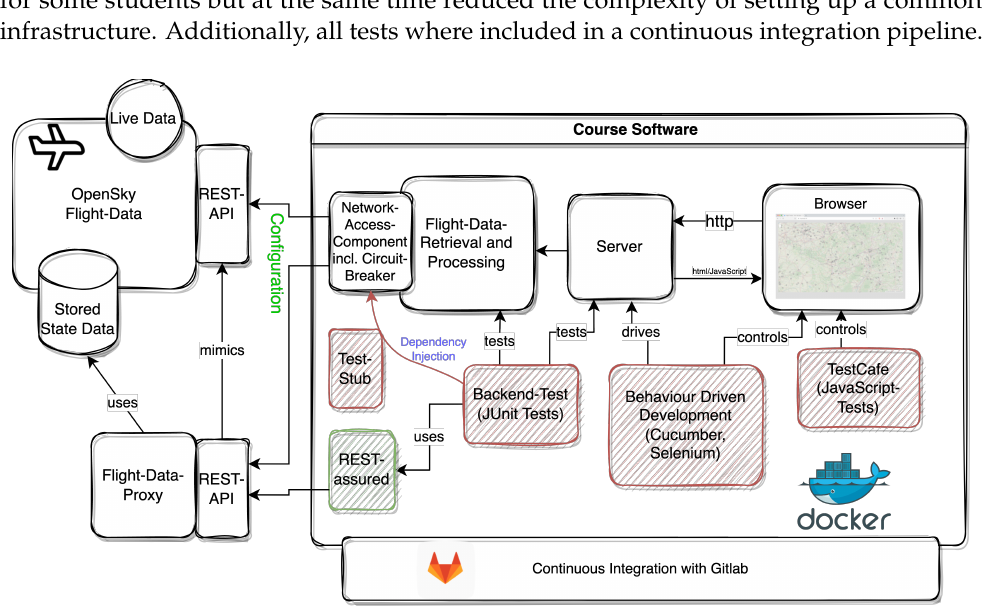
Figure 1. Overview of components and